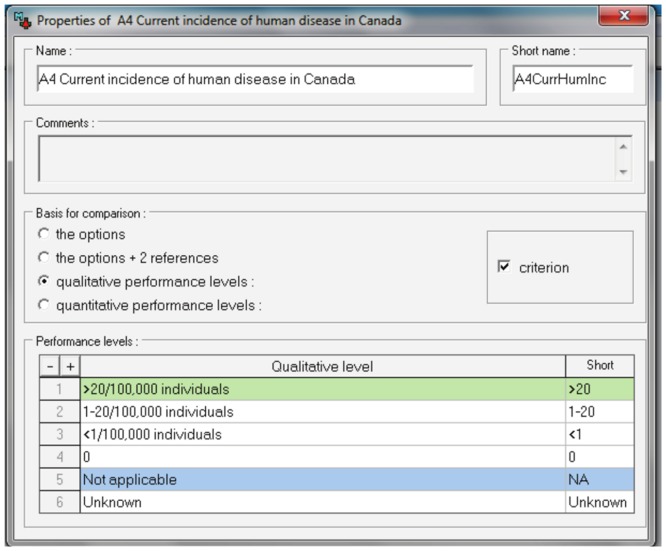
Properties of criteria A4: “Current incidence of human disease in Canada”, showing the 6 different attributes.Lower (blue) and upper (green) act as the scale's arbitrary values of 0 and 100 respectively.